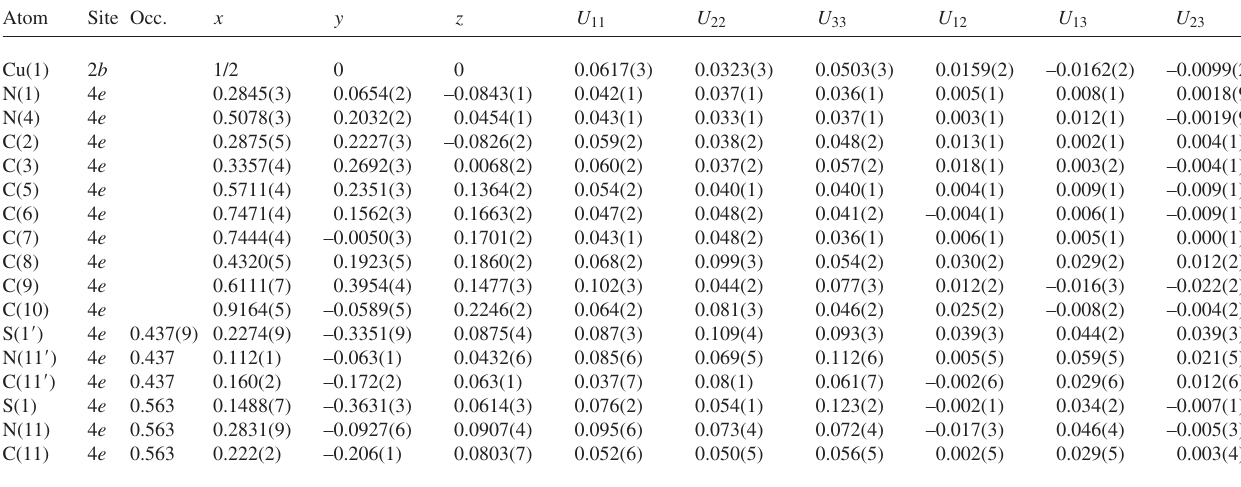
Table 3. Atomic coordinates and displacement parameters (in Å 2 )